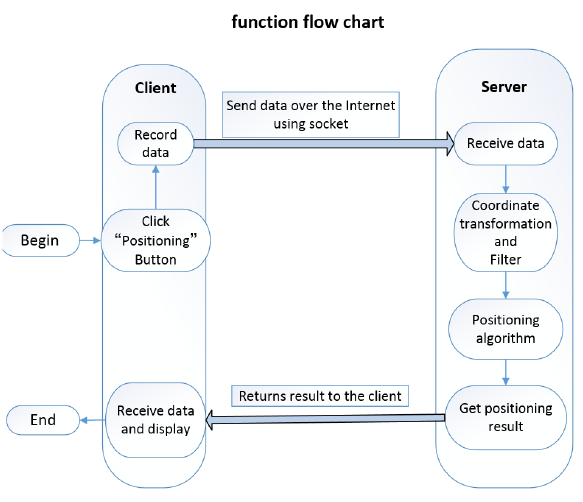
Figure3 Localization flow